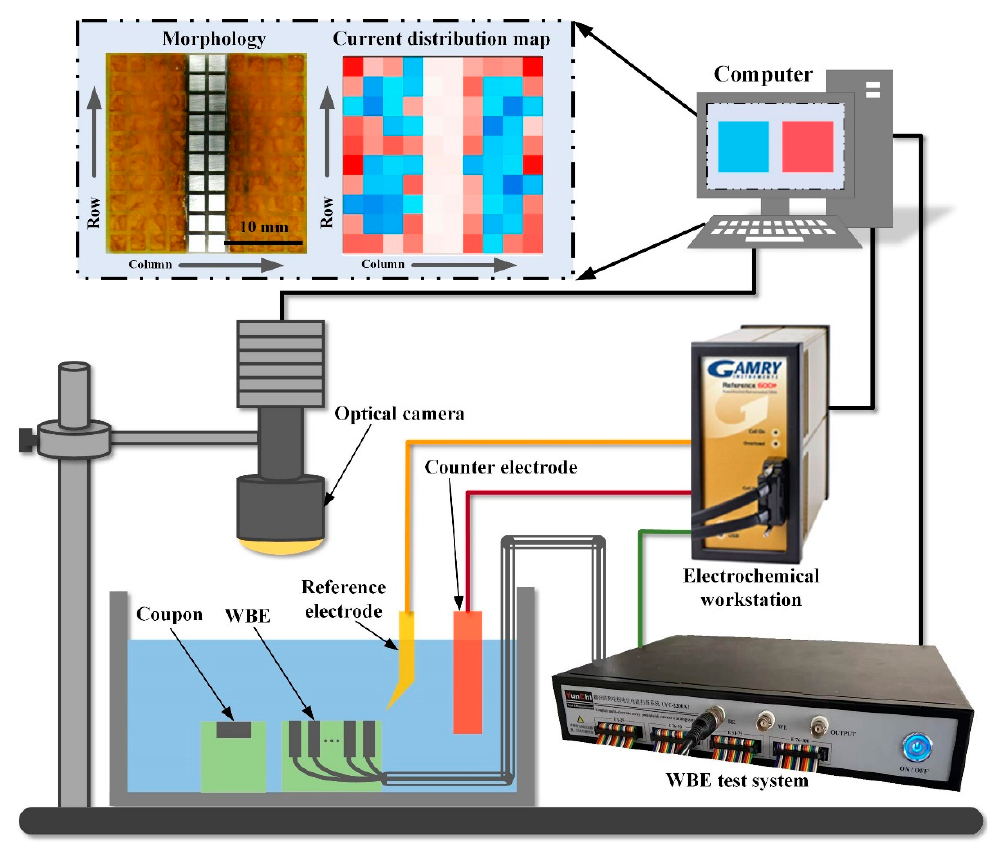
Figure 2. Schematic diagram of the electrochemical test system combined with real-time camera monitoring.